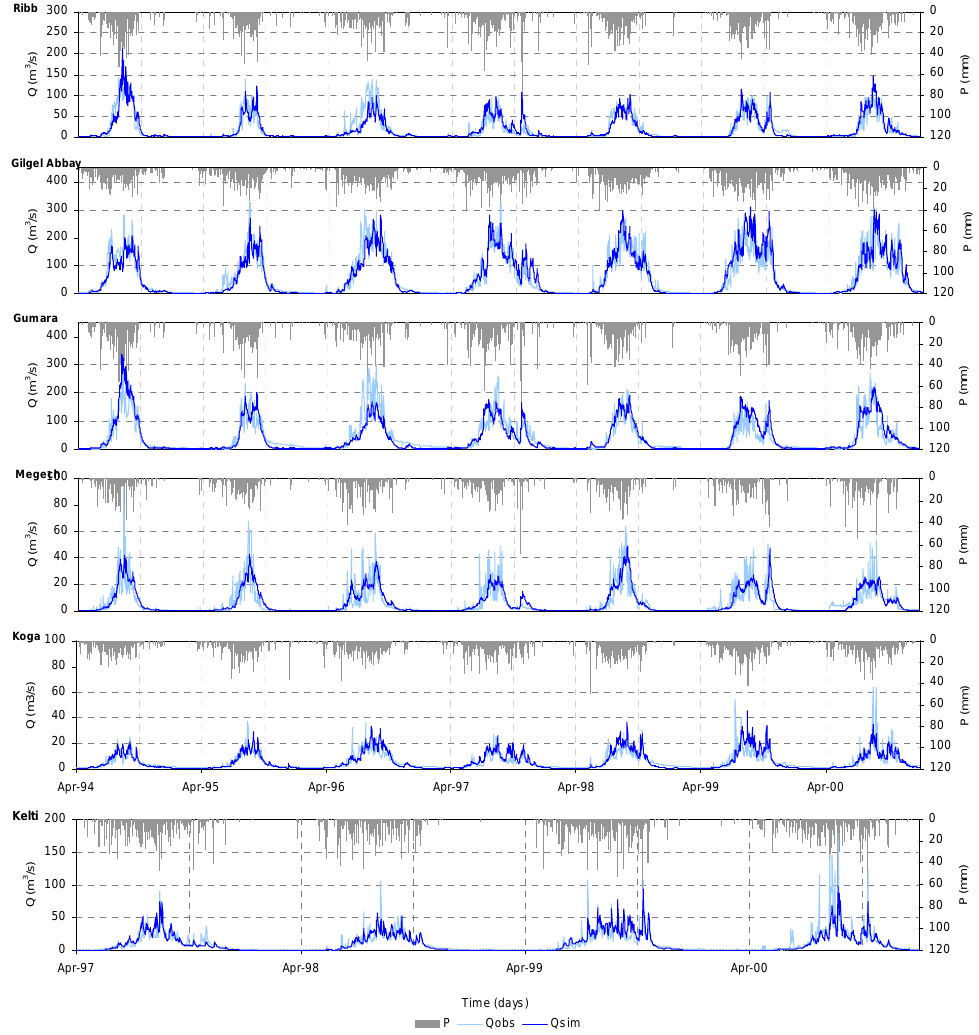
Fig. 5. Model calibration results of Ribb, Gilgel Abay, Gumara, Megech, Koga (1994–2000) and Kelti (1997–2000) Figure 5: Model calibration results of Ribb, Gilgel Abay, Gumara, Megech, Koga (1994-2000) and Kelti (1997-2000) catchments